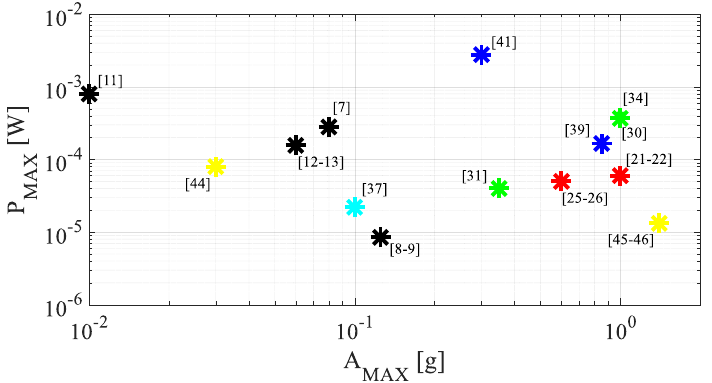
Figure 26. Summary of the power performance of analyzed MTTs. P MAX as a function of the acceleration amplitude A MAX . The various MTTs are identified with different colors. Black for “Magnetic Forces Based MTTs”, red for “Piezoelectric Actuators Based MTTs”, green for “Axial Loads Based MTTs”, cyan for “Clamp Position Change Based MTTs”, blue for “Variable Reluctance Based MTTs” , and yellow for “Variable Center of Gravity MTTs”.